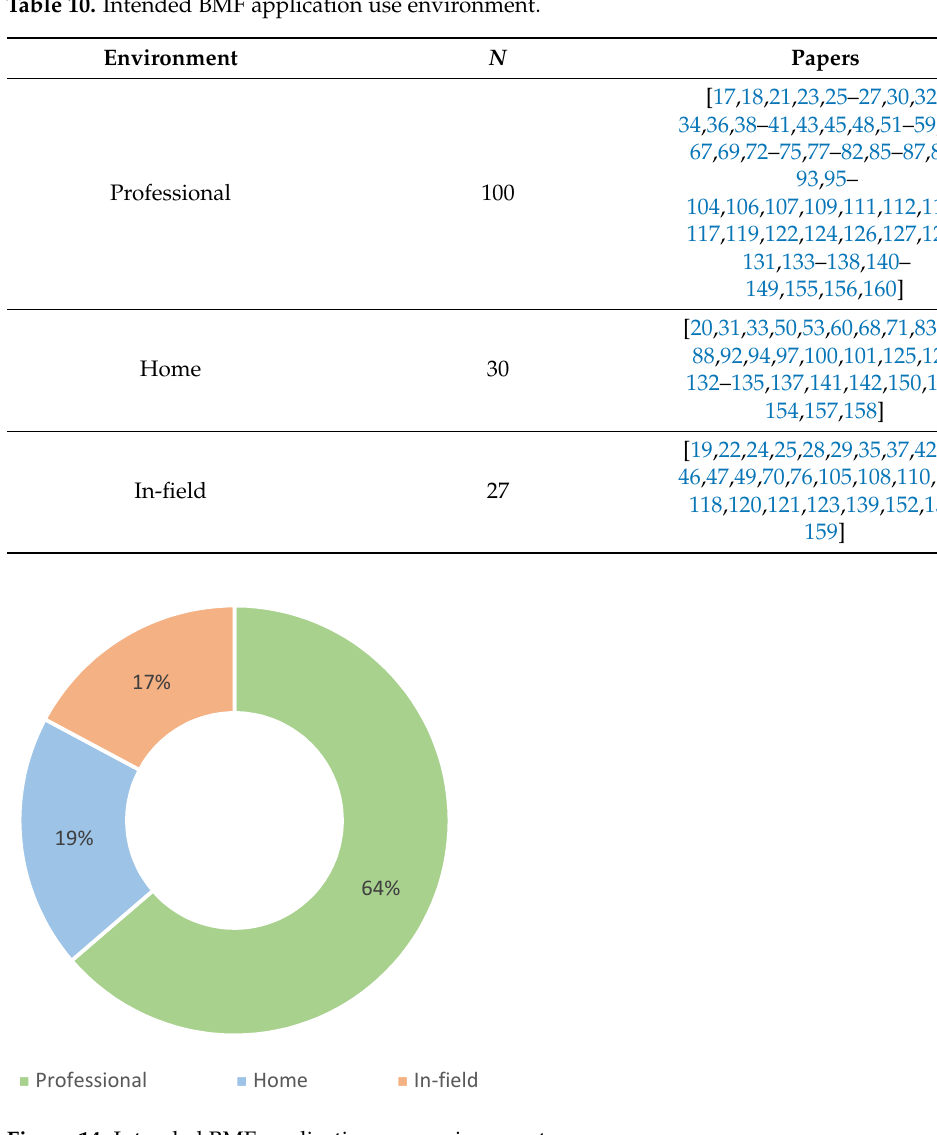
Figure 14. Intended BMF application use